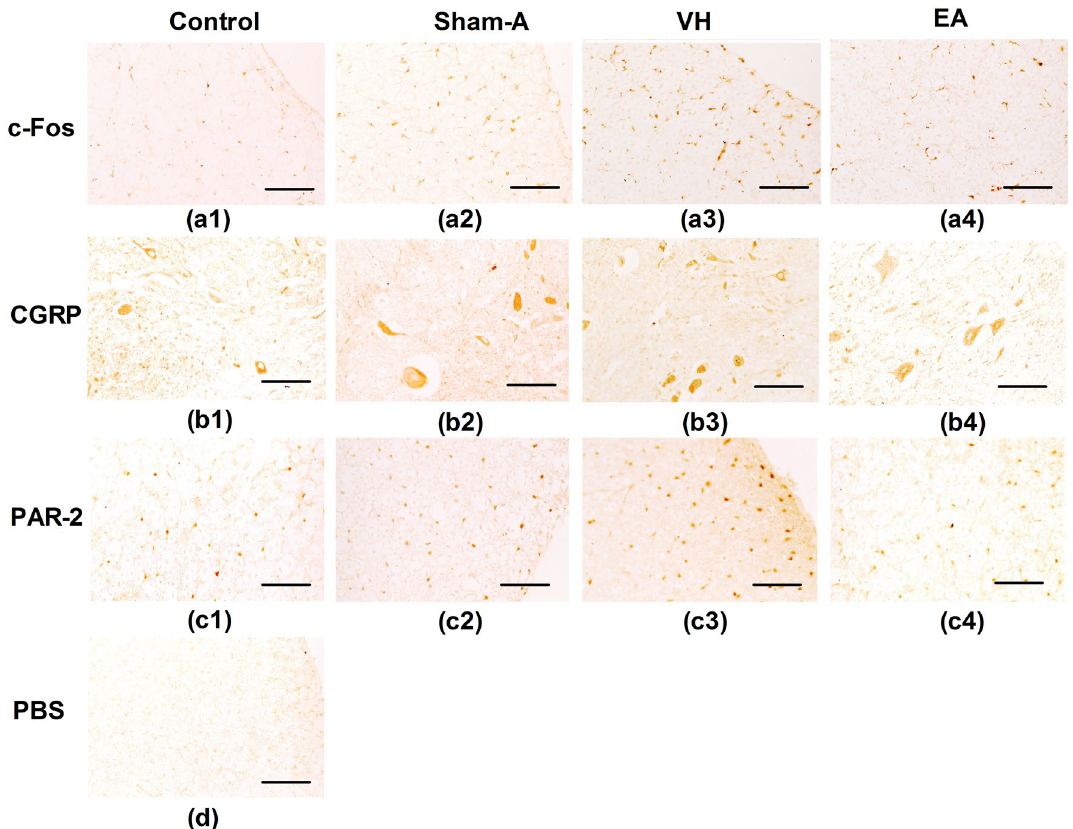
Figure 4. Distribution of PAR-2, CGRP and c-Fos proteins (20 ×) in the spinal cord of the goats on day 22 (n = 6). c-Fos positive neurons in the dorsal horn of spinal cord of Control ( a1 ), Sham-A ( a2 ), VH ( a3 ) and EA group ( a4 ). CGRP positive neurons (browns) in the dorsal horn of the spinal cord of Control ( b1 ), Sham-A ( b2 ), VH ( b3 ) and EA group ( b4 ). PAR-2 positive neurons (browns) in the dorsal horn of spinal cord of Control ( c1 ), Sham-A ( c2 ), VH ( c3 ) and EA group ( c4 ). Dorsal horn of spinal cord of PBS (d). Brown stain shows the nuclei of positive cells or cytoplasm. Scale bars = 50